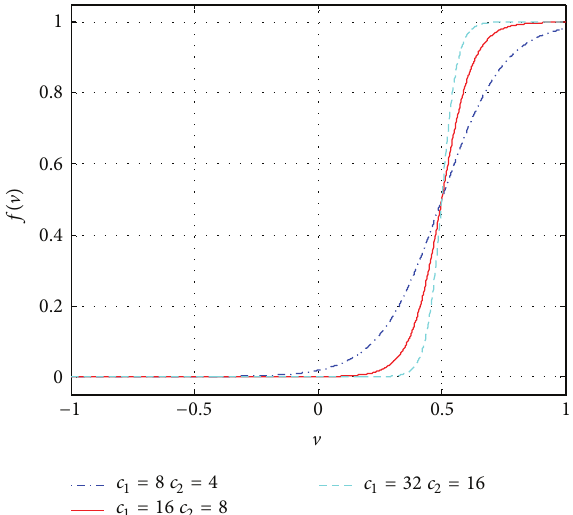
Figure 4: The variation of the adopted sigmoid function with different parameter